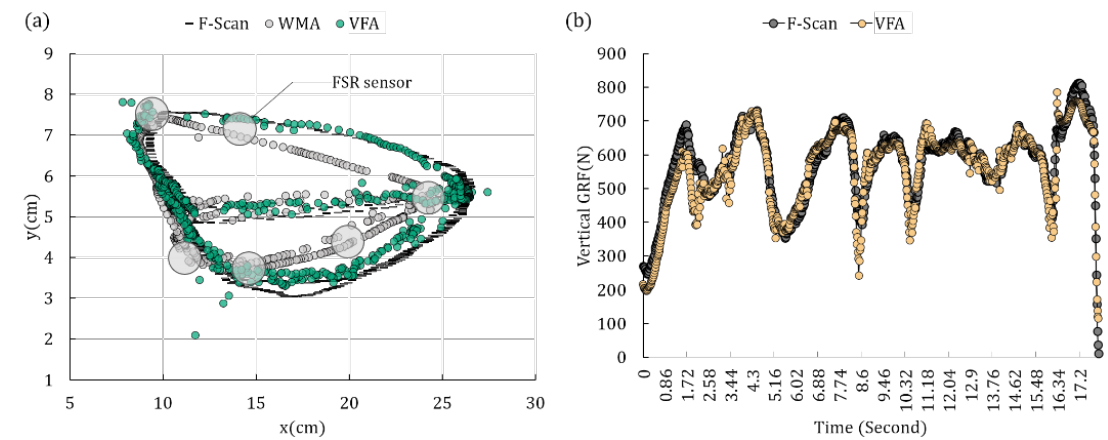
Figure 6. ( a ) The CoP trajectory plot during the scan experiment by the WMA, VFA and F-Scan. The gray circles with bold edges indicate the locations of the FSR sensors. ( b ) One Chosen GRF trajectory plot during the scan experiment by the VFA and F-Scan.